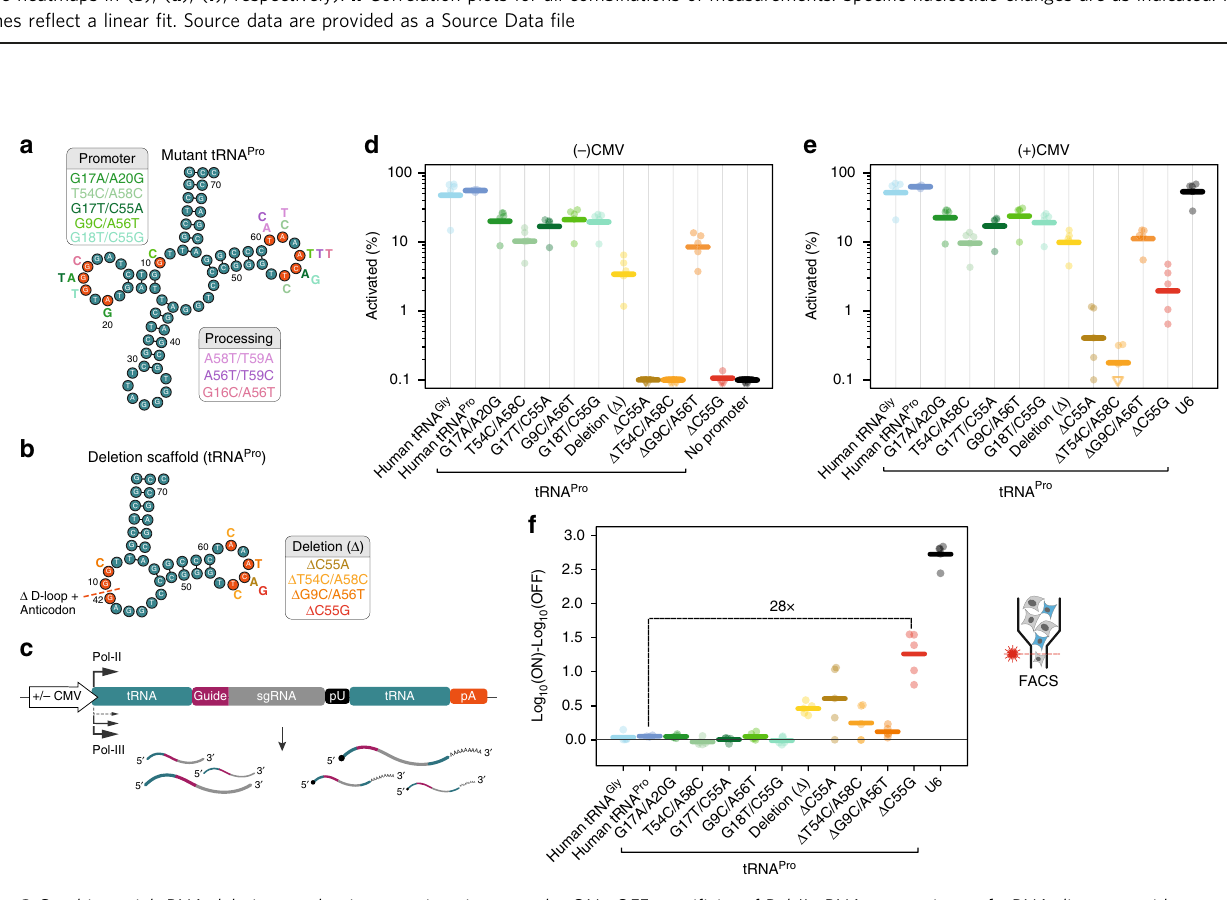
Fig. 2 Mutagenesis screen identi fi es sequence determinants of tRNA processing and promoter activities. a Experimental design for a tRNA mutagenesis screen in human cells. Parallel libraries of partially degenerate tRNA Pro were created (dark orange = mutated positions), with and without a CMV promoter. Degenerate barcodes (light orange) were placed between the gRNA and tRNA sequences to allow variant identi fi cation following processing. A short buffer sequence was included between the barcode and the tRNA to protect the barcode from cleavage. RNA species from ( + )CMV libraries were decapped to avoid the 5 ′ cap-mediated inhibition of RNA circularization. b , d , f Heatmaps showing the effects of all single mutations at each nucleotide position on promoter activity ( n = 3 paired pDNA/circRNA libraries with no Pol-II promoter) ( b ), 3 ′ processing ( n = 3 paired pDNA/circRNA libraries with no Pol-II promoter) ( d ), and 5 ′ processing ( n = 3 paired pDNA/circRNA libraries with CMV promoters) ( f ) (hatched squares = wild-type nucleotides; black squares = no measurement). In ( b ) promoter activity was calculated as the ratio of observed reads in the RNA fraction of a given mutation compared to its expected frequency in the library from sequencing the plasmid DNA (green borders = changes from wild type with a probability of 80% or greater, BEST test; only mutations with observations in all three libraries were included in signi fi cance testing). In d , f processing ef fi ciency was inferred by averaging the binomial probability distributions (processed of total reads) across replicates then taking the point of highest probability as the fi nal value estimate (green borders = changes from wild type with probability densities overlapping by less than 5%). c , e , g Corresponding tRNA diagrams showing for each modi fi ed position, the mutation which rendered the lowest (left) and highest (right) levels of their respective measurements (colors correspond to the heatmaps in ( b ), ( d ), ( f ), respectively). h Correlation plots for all combinations of measurements. Speci fi c nucleotide changes are as indicated. Red